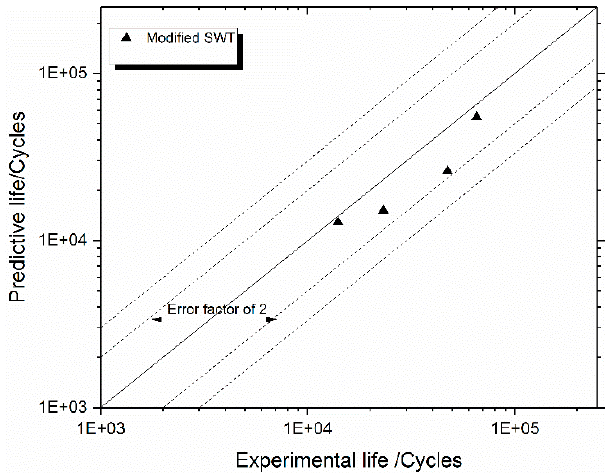
Figure 14. Comparison of predicted lives with experimental lives for TC11.